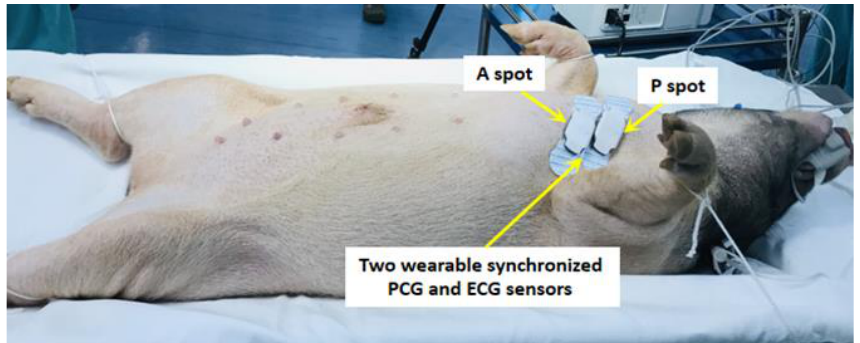
Figure 2. Two wearable synchronized phonocardiogram (PCG) and electrocardiogram (ECG) sensors are attached to the aortic valve second auscultation area (A spot) and pulmonary auscultation area (P spot) on the swine’s left chest surface, respectively.